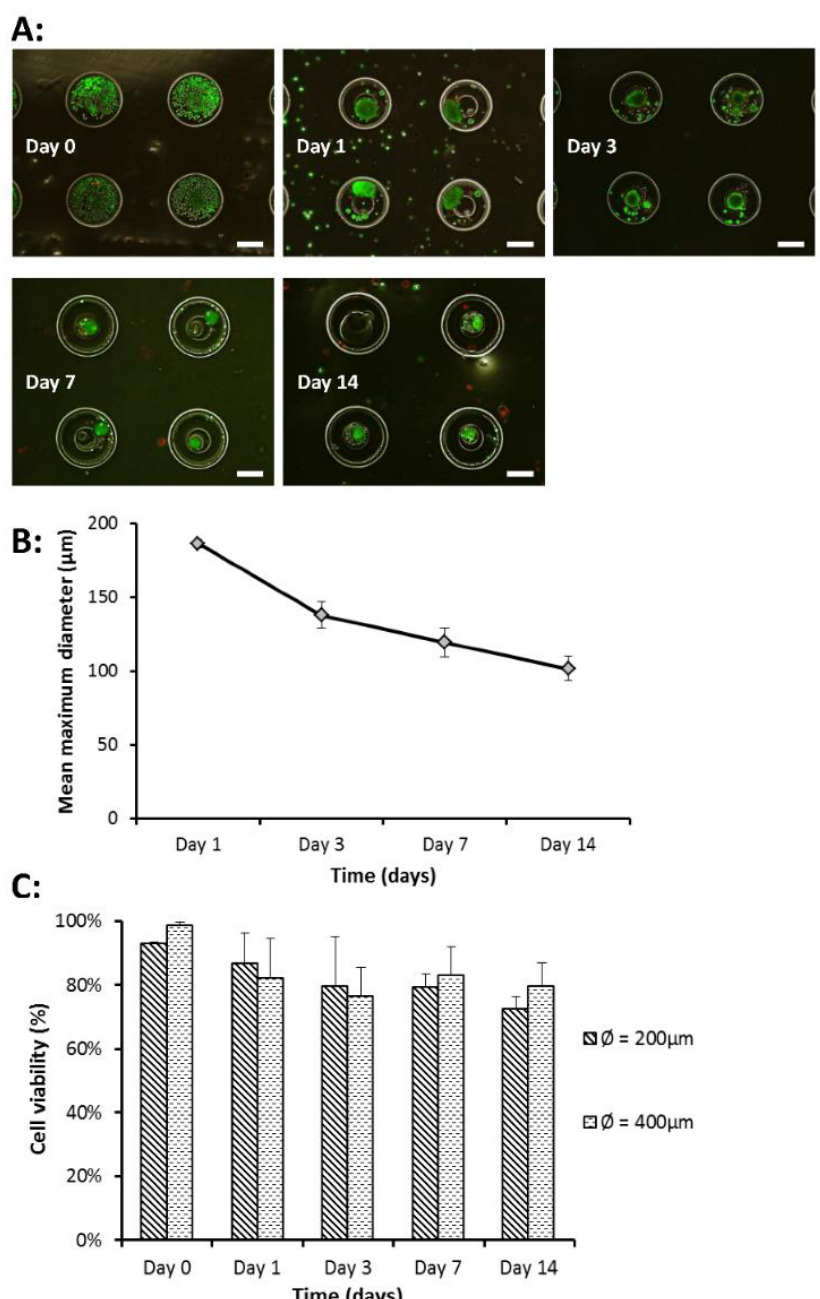
Figure 5. HaCat Cell viability in hydrogel microwell array. ( A ) Merged fluorescence images of live/dead assay performed on seeded HaCaT cells (400 μm microwell). Green fluorescence indicates live cells while red fluorescence indicates dead cells. Day 0 shows successful seeding of HaCaT cells in the microwells. Cell aggregates formed on day 1 and persisted till day 14. Scale bar = 200 μm. ( B ) Mean maximum diameter (μm) of cell aggregates over time (days). Cell aggregates were largest on day 1 at 186 (±2.9) μm on day 1. Agg regate size showed a gradual decreasing trend over the 14 days and final aggregate size was 101 (±8.3) μm on day 14. Each data point represents the mean ± SD ( n = 4). ( C ) HaCaT cell viability in percentage over time (days). Cell viability was calculated by taking fluorescence intensity of live cells over total fluorescence intensity of live and dead cells. There was no significant difference between cell viability in both microwell designs ( p = 0.74). Each data point represents the mean ± SD ( n = 6).